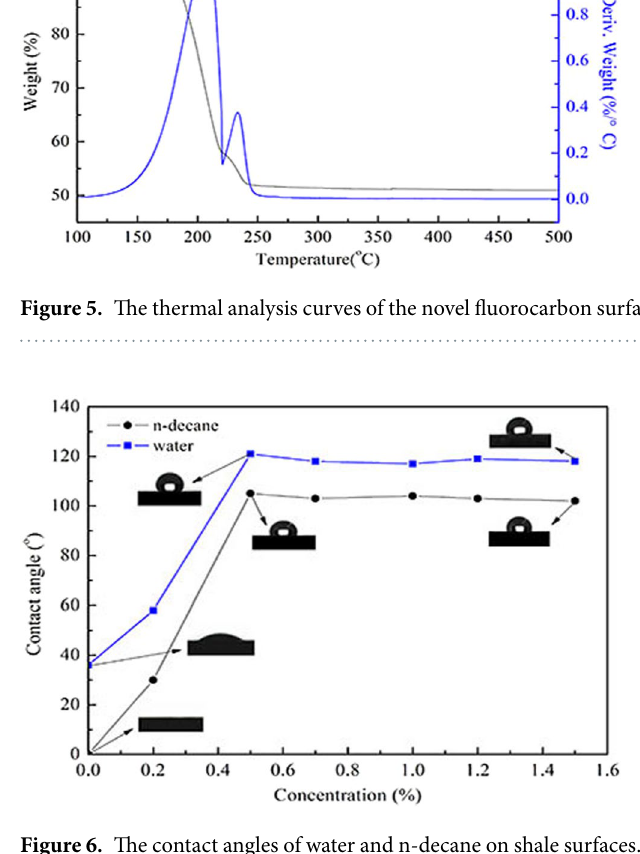
Figure 6. The contact angles of water and n-decane on shale